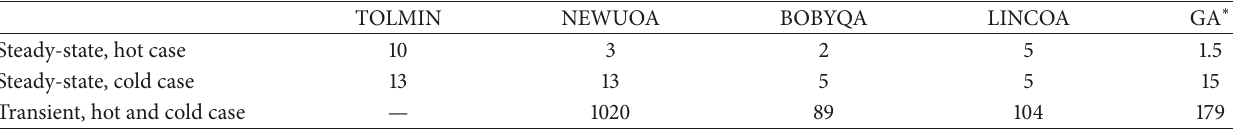
Table 7: CPU times (in seconds).